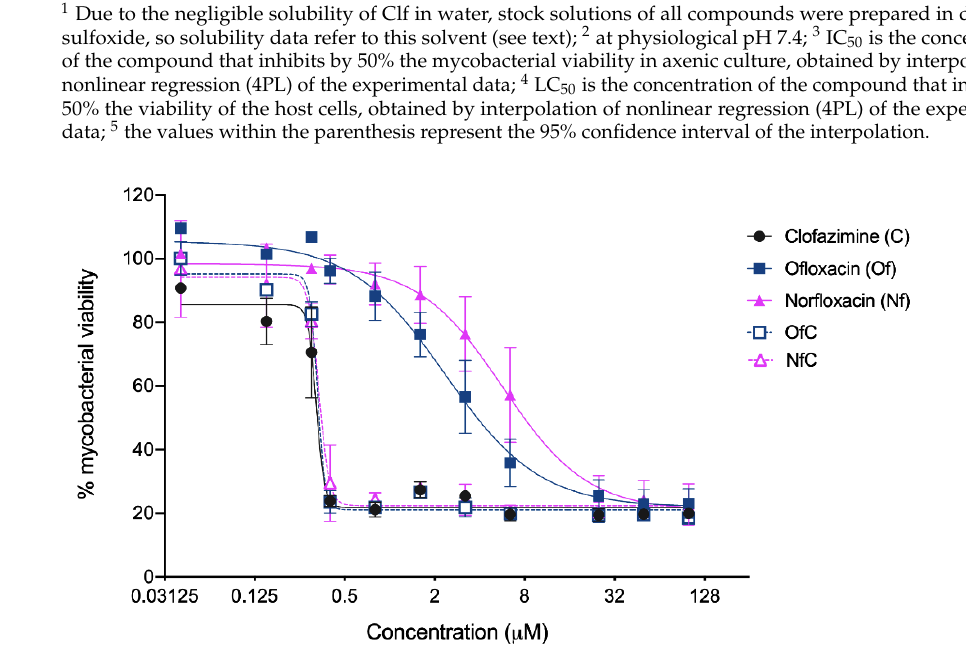
Figure 4. Toxicity of the Clf-derived OSs and their parent drugs to host mammalian cells (murine BMM). The symbols represent the averages ± standard deviations of two to three independent ex- periments, presented as percentages of viable macrophages relative to non-treated macrophages. The lines represent the non-linear 4PL regression obtained in the GraphPad software for each ex- perimental condition. Then, to test the activity of the compounds against intracellular mycobacteria, BMM infected with M. avium 2447 SmT were treated with three concentrations of the test com- pounds that were not toxic to the macrophages (0.1, 0.3 and 0.5 μM) for 5 days at 37 ° C and 7% CO 2 . The intracellular bacterial loads were quantified by the colony-forming units (CFUs) assay (Figure 5). Relevantly, even though the Clf-derived OSs were less active than the parent Clf, they still reduced the bacterial load up to 80% at the tested concentrations, being considerably more active against intracellular M. avium than their parent fluoro- quinolones.